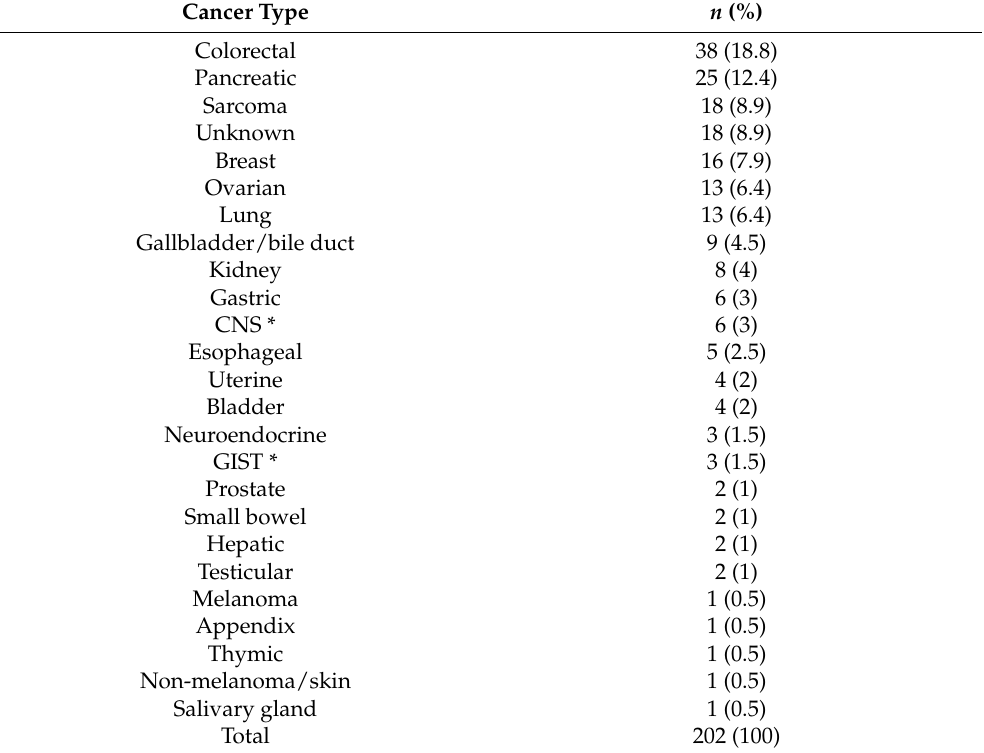
Table 1. Distribution of cancer types in this